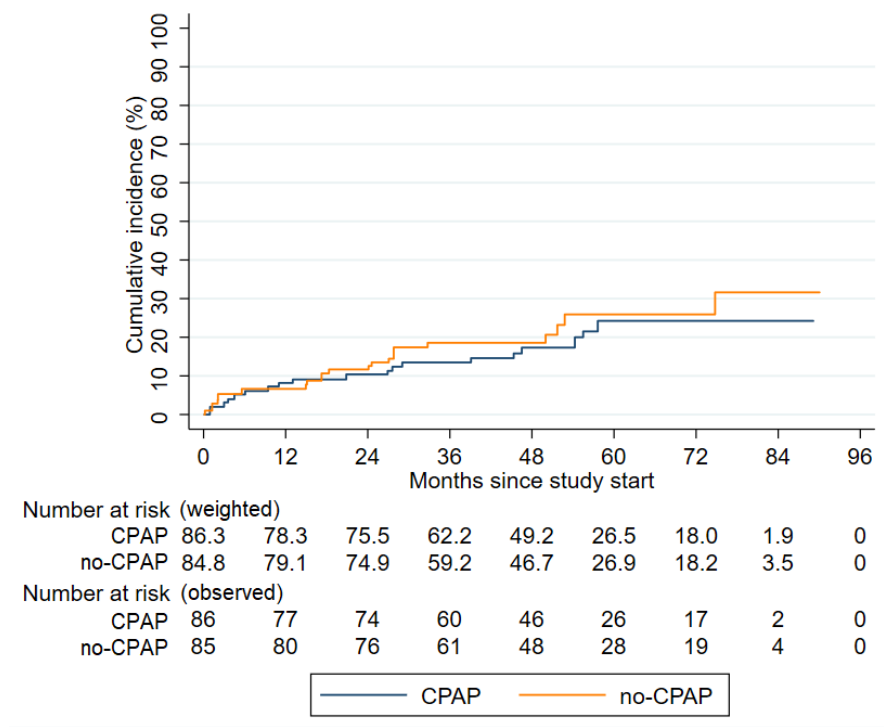
Figure 2. Cumulative incidences of the composite endpoint in the intention-to-treat population. CPAP, continuous positive airway pressure; OSA, obstructive sleep apnea.